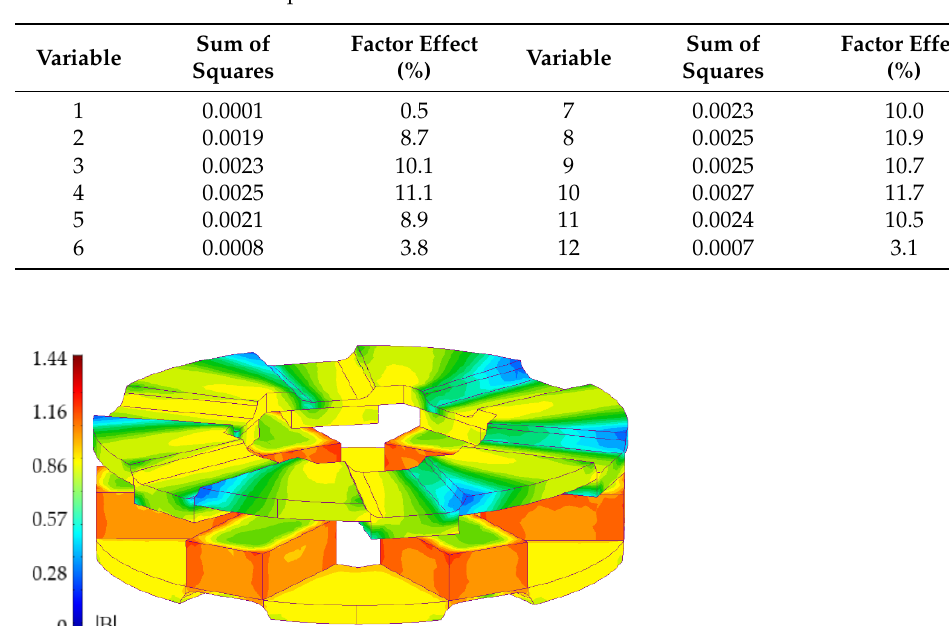
Table 4. Effects of different parameters on the cost function.